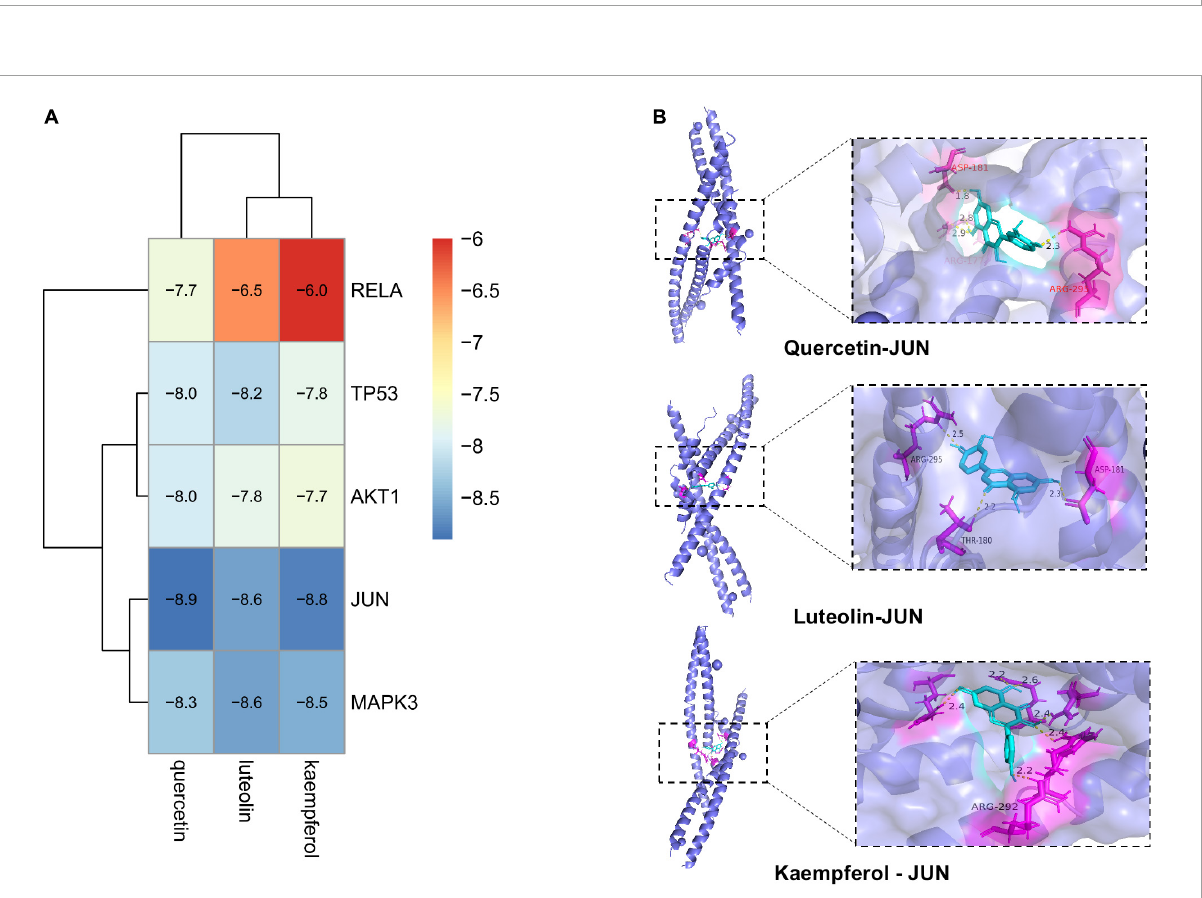
FIGURE9 Diagram of molecular docking results. (A) Heat map of binding energy between the compounds of A. argyi and A. indica and core target molecule docking. The smaller the value the stronger the combination. (B) Docking model diagram of the compound and key target